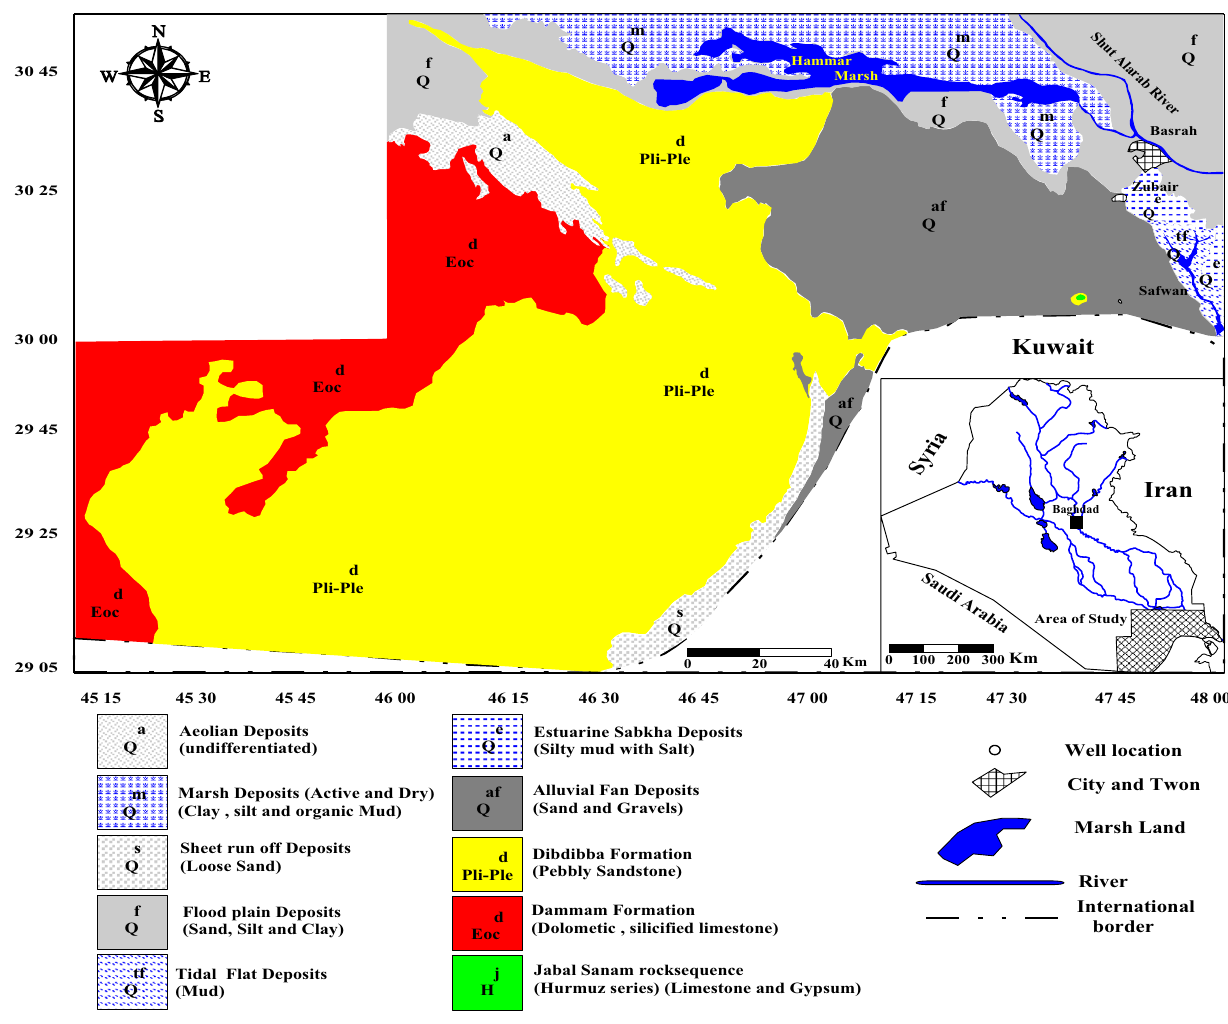
Fig. 2 Geological map of the area (Yacoub 1992) modified by author Table 1 Statistical data show hydrogeological properties of aquifer Statistics Elevation (m) Static w.